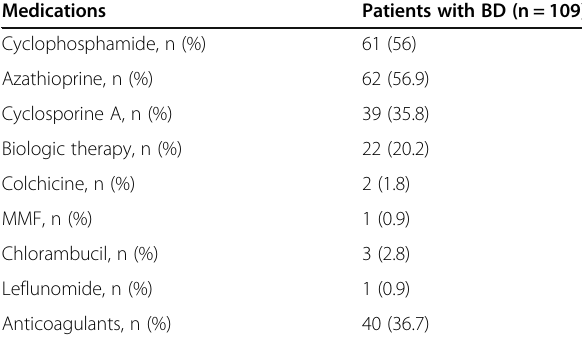
Table 2 Medications received by patients with Behçet ’ s disease Medications Patients with BD (n =